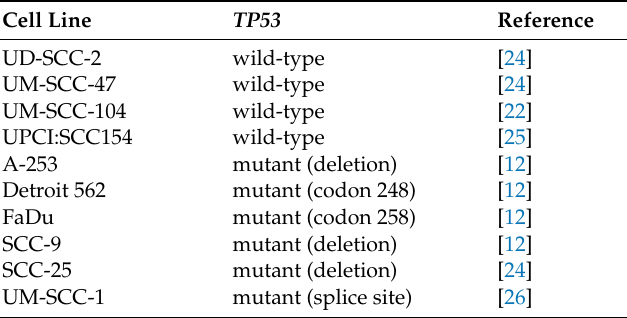
Table 3. TP53 mutation status for the cell lines used in this